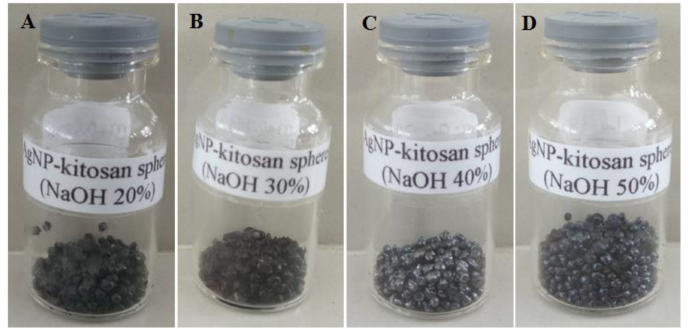
Figure 2. Products of AgNPs-chi-spheres. ( A ) AgNPs-chi-spheres 1 (NaOH 20%); ( B ) AgNPs-chi- spheres 2 (NaOH 30%); ( C ) AgNPs-chi-spheres 3 (NaOH 40%); ( D ) AgNPs-chi-spheres 4 (NaOH